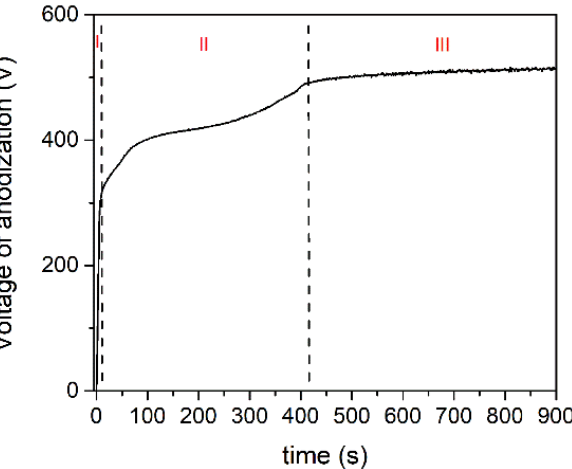
Figure 1. Voltage-time curve during anodization of tantalum at 150 mA/cm 2 in Na 3 PO 4 ·10H 2 O. The process of tantalum anodization can be separated into three stages based on the voltage–time response. Total anodizing current density is the sum of ionic and electron current densities [40]. During the anodic growth in stage I, the electric field strength for a certain current density remains constant, and the ionic current is two to three orders of